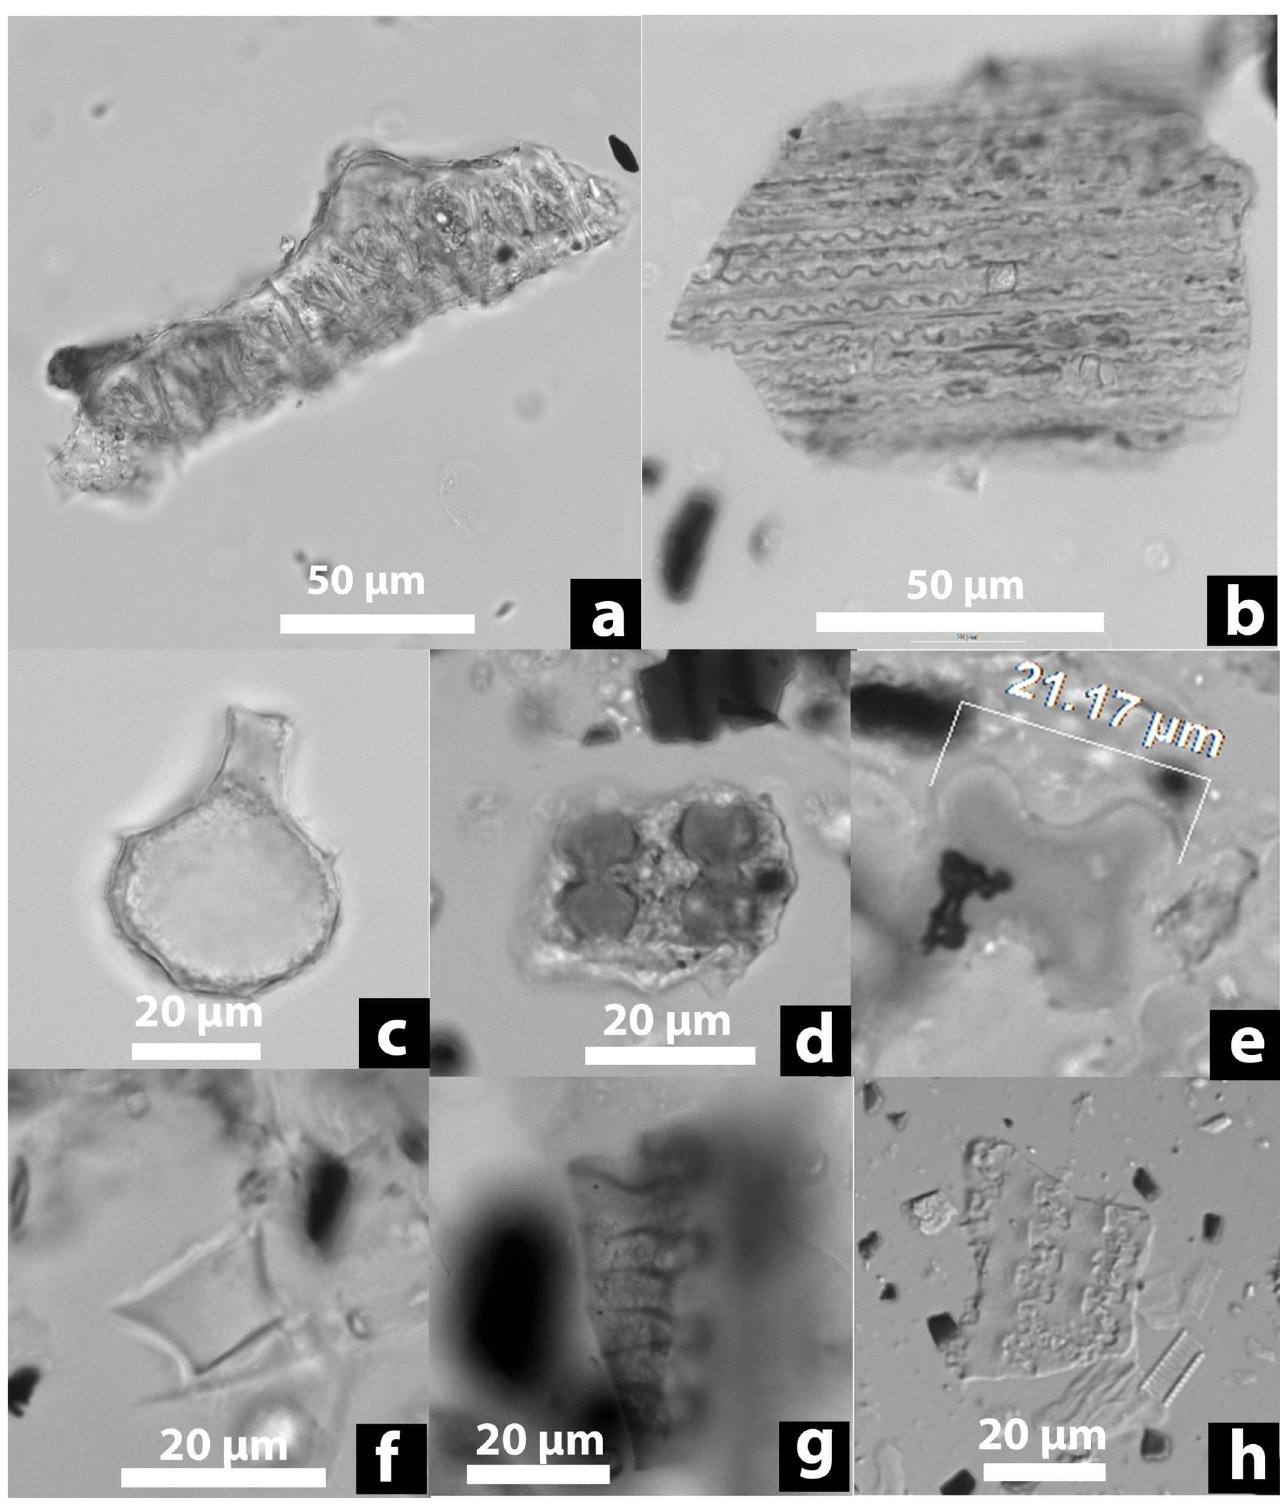
Fig 7. Phytolith remains from Qiaotou pottery. (a) Double peak (Oryza, rice husk); (b) elongate skeletons (Poaceae); (c) Oryza-type bulliform (Oryza, rice leaf/ stem); (d) Parallel scooped bilobate (Ehrhartoideae); (f) Cross (cf. Job’s tears); (g) Rondel (Poaceae); (h) Articulated quadrilobate (Panicoideae) (i) Crenate elongate skeleton (cf. Poaceae